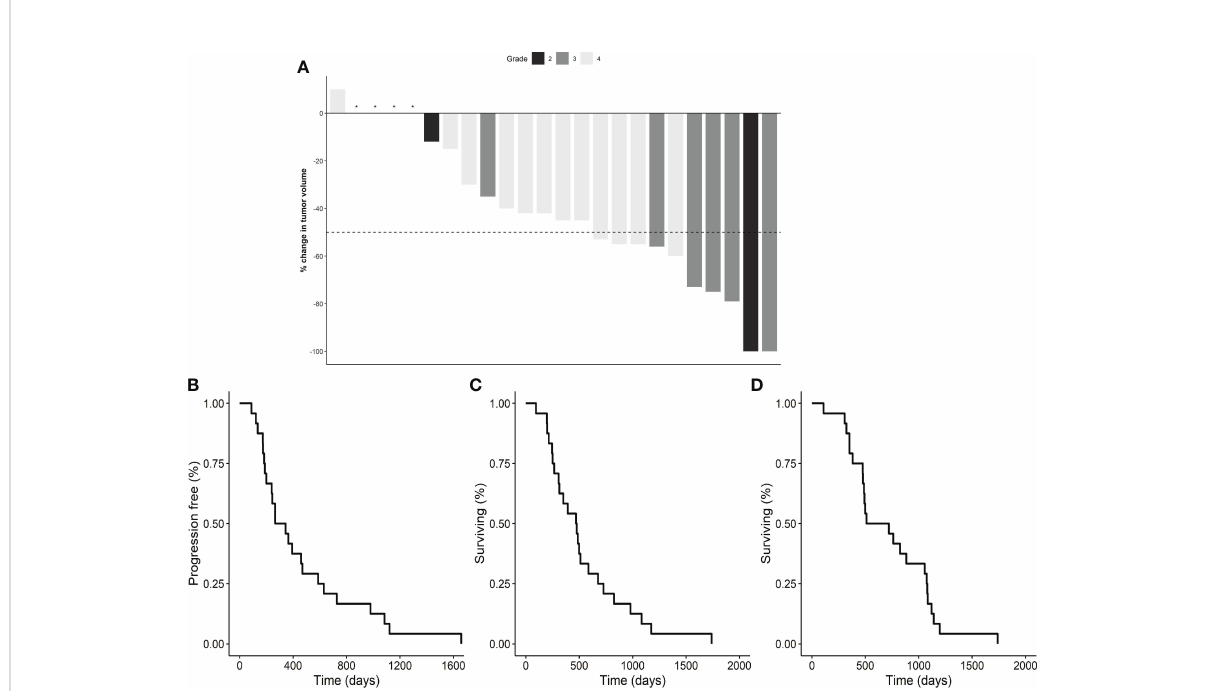
FIGURE 8 Deracoxib early intervention results. A waterfall plot of the percentage change in tumor volume in individual dogs treated with deracoxib is provided in panel (A) . Responses included: CR in two dogs (8%), PR in eight dogs (33%), and SD in 14 dogs (58%). The gray scale denotes tumor grade (see key). Kaplan-Meier survival curves are included for progression free interval (PFI) ((B) , median 304 days ) , deracoxib-related survival ((C), median 473 days ) , and overall survival ((D), median 615 days ) . Following deracoxib failure, eight dogs received intravenous chemotherapy (carboplatin, vinblastine, mitoxantrone), and seven dogs received oral therapies (chlorambucil, toceranib, piroxicam). Distant metastases were present in 26% of dogs at death. Six dogs died from non-urinary cancer related causes. CR, complete remission, no clinically detectable cancer remaining; PFI, progression free interval; PR, partial remission, ≥ 50% reduction in tumor volume; SD, stable disease, < 50% change in tumor volume. "*" indicates no change in tumor volume.